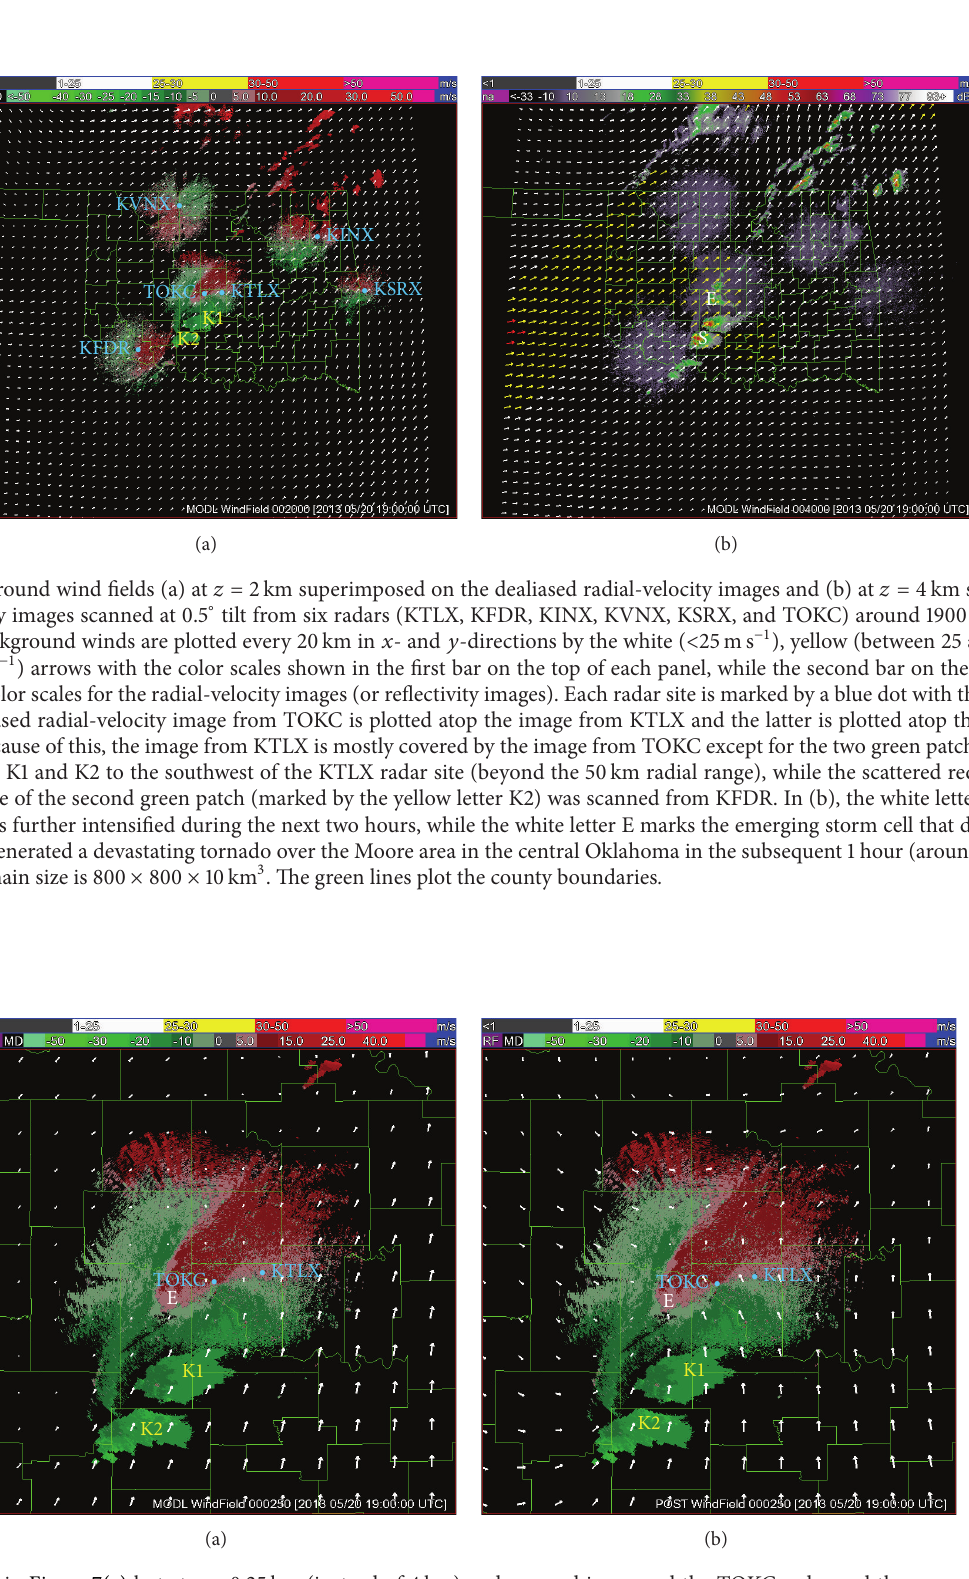
Figure 8: (a) As in Figure 7(a) but at 𝑧 = 0.25 km (instead of 4km) and zoomed in around the TOKC radar and the emerging storm cell marked by the white letter E as in Figure 7(b). (b) As in (a) but for the analyzed wind field produced by the upgraded RWAS. The dealiased radial-velocity images are shown only for the TOKC and KTLX radars with the image from TOKC plotted atop the image from